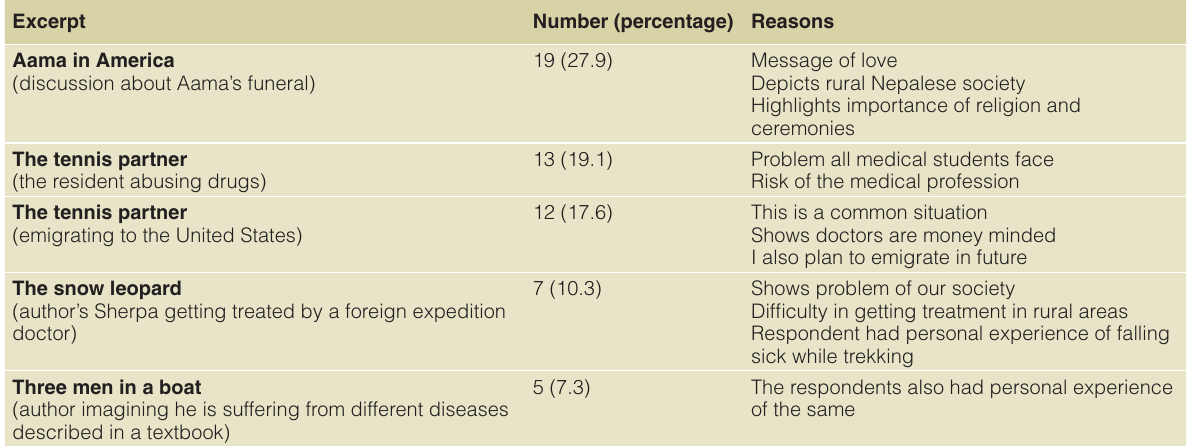
Table 3. Literature excerpts with which respondents identified the most along with